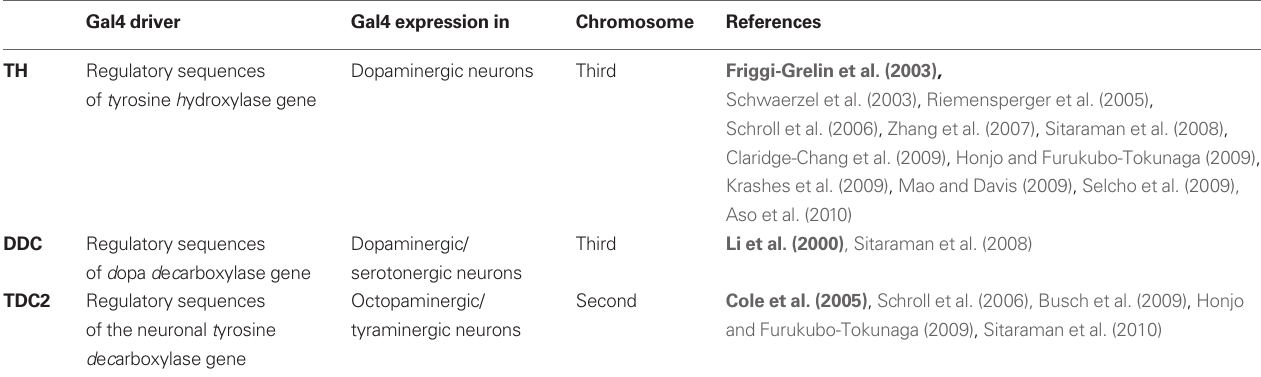
Bold font indicates the original report of the respective Gal4